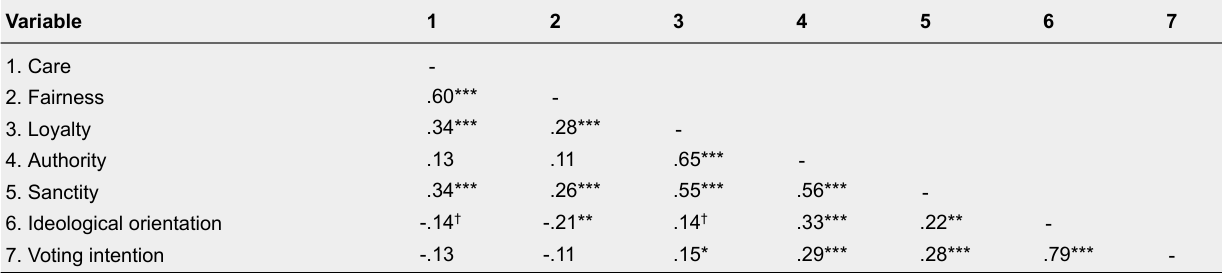
Note. Ideological orientation: from 1 = left-wing oriented to 5 = right-wing oriented. Voting intention coded as 0 = intention to vote for the opposition left-wing party Partito Democratico; 1 = intention to vote for the incumbent right-wing party Popolo della Libertà. † p < .06. * p < .05. ** p < .01. *** p < .001.